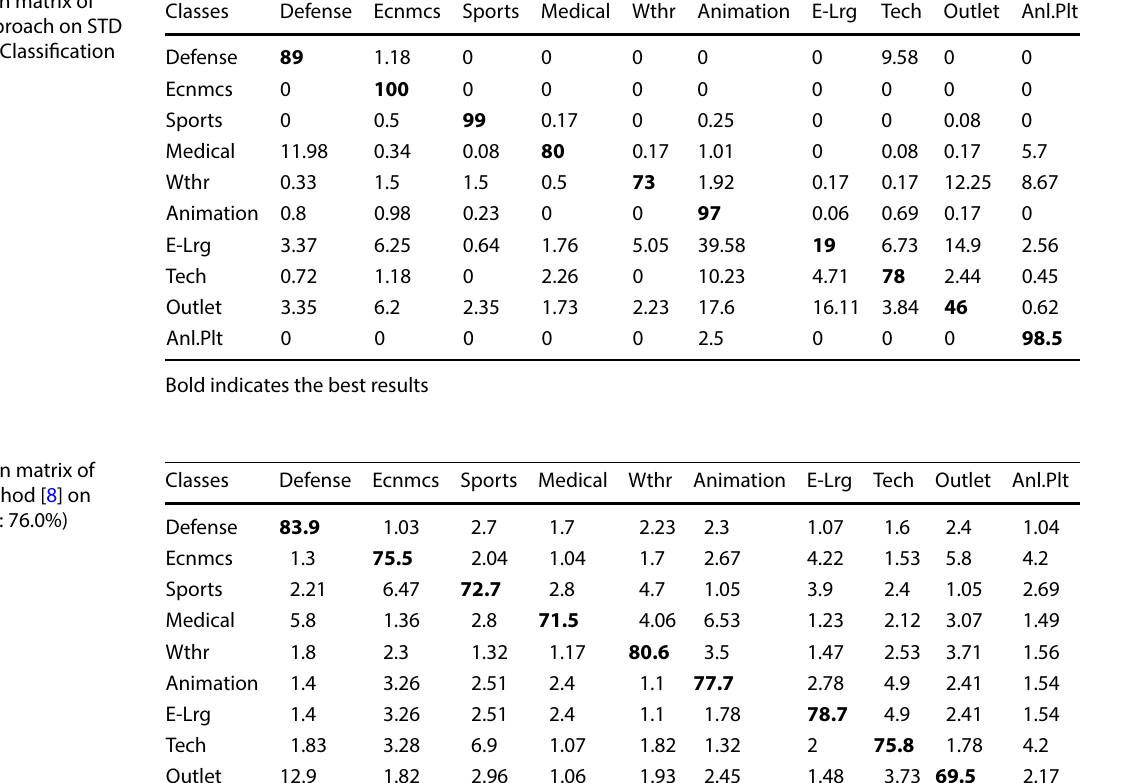
Table 3 Confusion matrix of the proposed approach on STD dataset (Average Classification Rate: 77.89%)